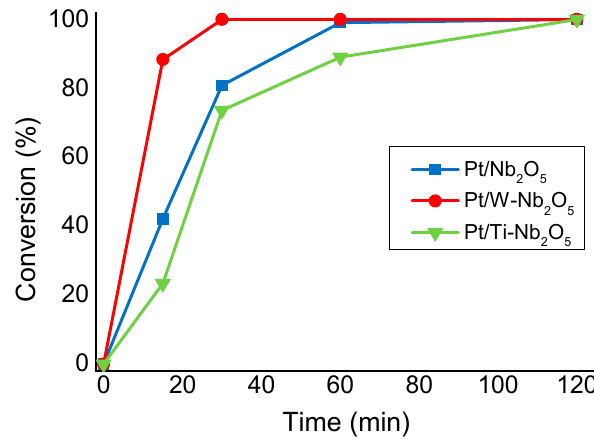
Figure 7. Furfural hydrogenation with Pt/Nb 2 O 5 , Pt/ W-Nb 2 O 5 and Pt/Ti-Nb 2 O 5 .